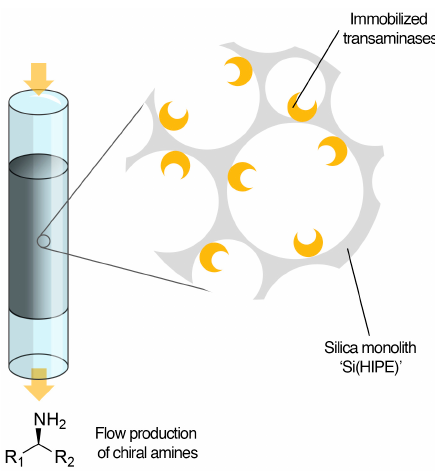
Figure 1. Transaminases have been immobilized on a macroporous silica monolith and used as biocatalyst for continuous flow transamination reaction. biocatalyst for continuous flow transamination